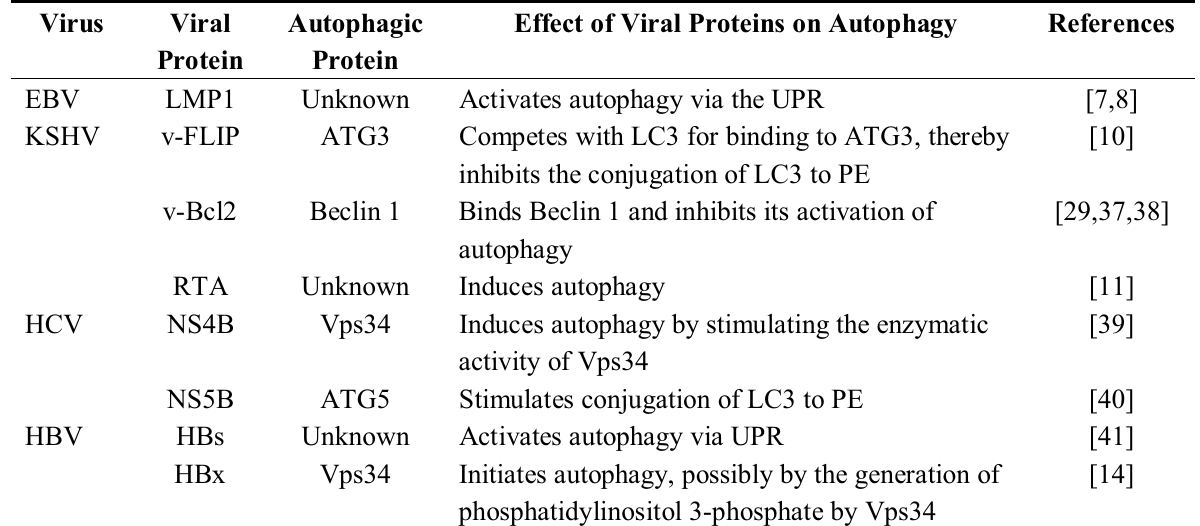
Table 3. Viral proteins that affect